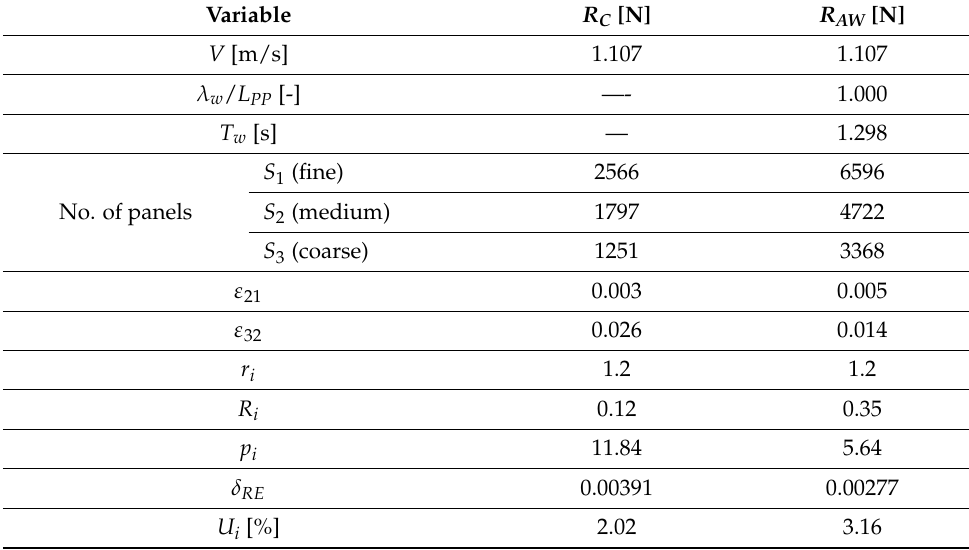
Table 4. Grid convergence test results.